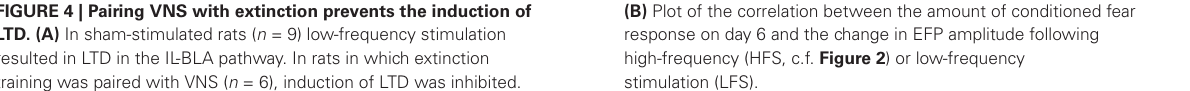
FIGURE 4 | Pairing VNS with extinction prevents the induction of LTD. (A) In sham-stimulated rats ( n = 9) low-frequency stimulation resulted in LTD in the IL-BLA pathway. In rats in which extinction training was paired with VNS ( n = 6), induction of LTD was inhibited.